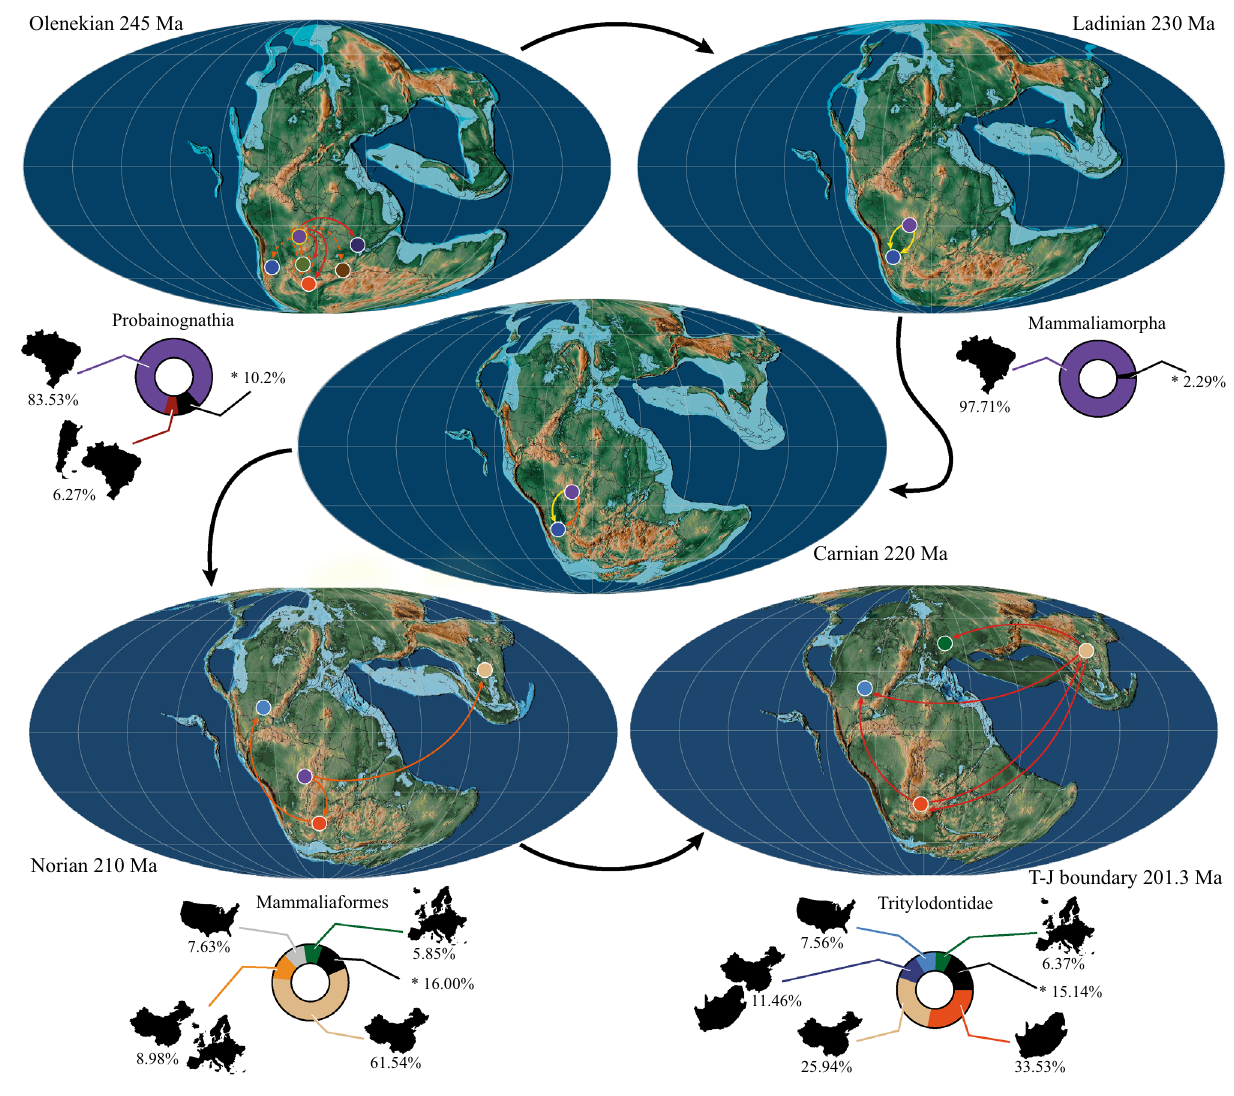
Figure 5. Paleogeographic reconstructions depicting dispersal events in different time-slices according to the RASP analysis and the time-calibrated majority rule consensus tree of the pruned data matrix. Areas are represented by circles: violet Paraná Basin (Brazil), blue Ischigualasto-Villa Unión Basin (Argentina), musk green Otiwarongo Basin (Namibia), orange Karoo Basin (South Africa), dark brown Morondava Basin (Madagascar), dark blue Ruhuhu Basin (Tanzania), light blue North American basins, light brown Lufeng Basin (China), and dark green European basins. Arrows in each time-slice represent dispersions at different moments of the corresponding age: yellow early, orange middle, and red late. Yellow-circled area in the paleogeographic reconstruction of the Olenekian time-slice represents that Probainognathia originated in the Paraná Basin (Brazil) by the early Olenekian. Dotted lines in the paleogeographic reconstruction of the Olenekian time-slice indicate that after the dispersion from the Paraná Basin (Brazil) to the Otiwarongo Basin (Namibia), a new joint area (Paraná- Otiwarongo basins) was established and from there dispersions occurred to the Ischigualasto-Villa Unión Basin (Argentina) and the Morondava Basin (Madagascar). Pie charts showing the probability of different ancestral areas for selected major clades. Asterisk depicts the probability of all those areas that have less than 5% probability of being the ancestral area of a node taken together. Paleogeographic reconstructions from 69